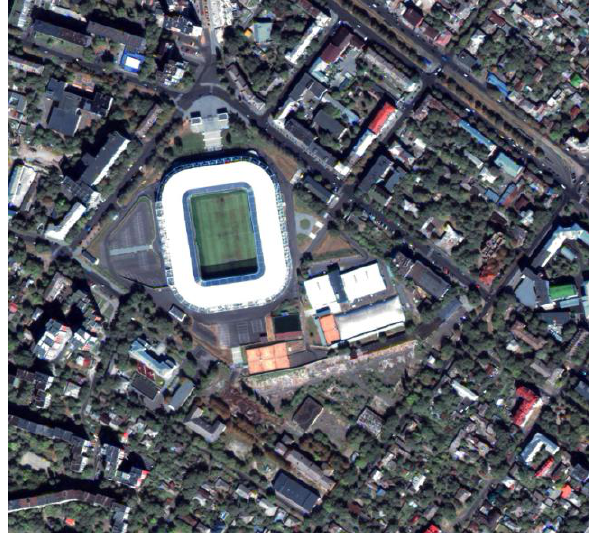
Figure 4. The fusion result of applying the proposed method